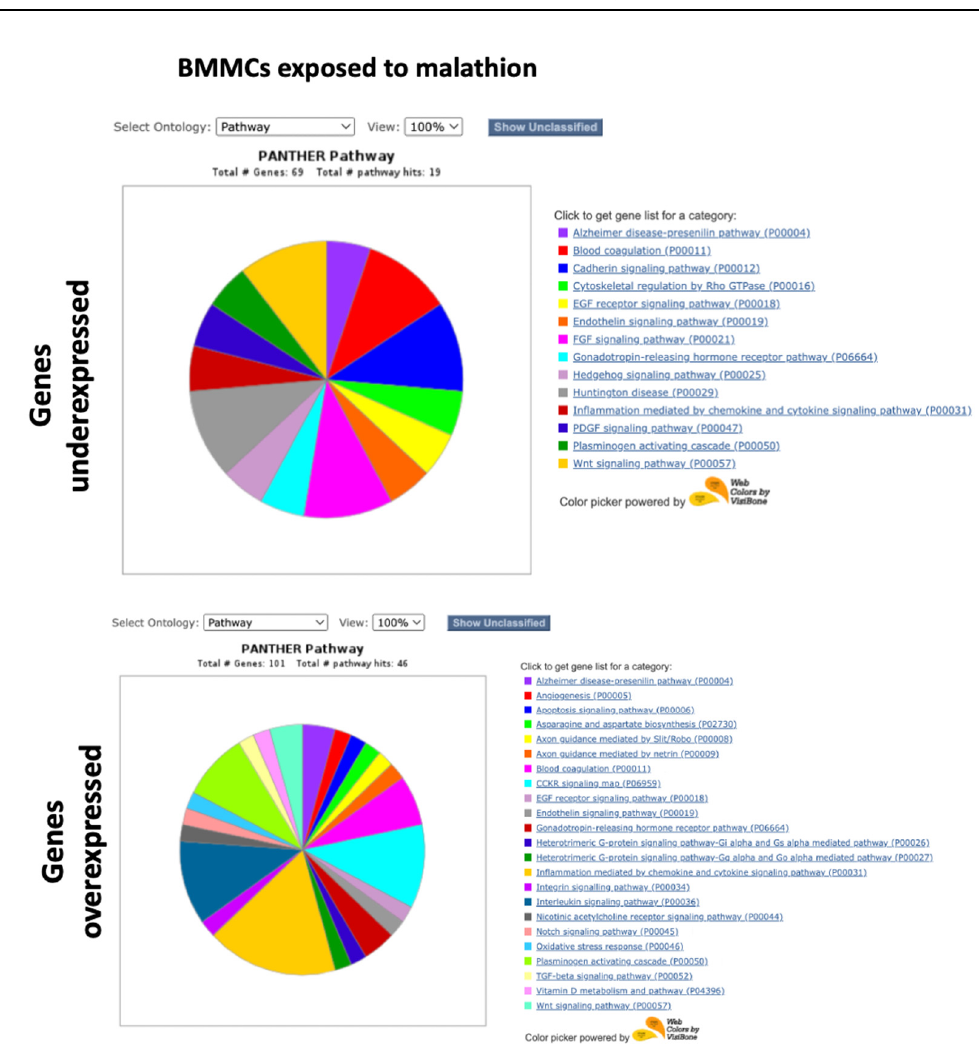
Figure 5. Pathway ontology analysis in BMMCs exposed to malathion.